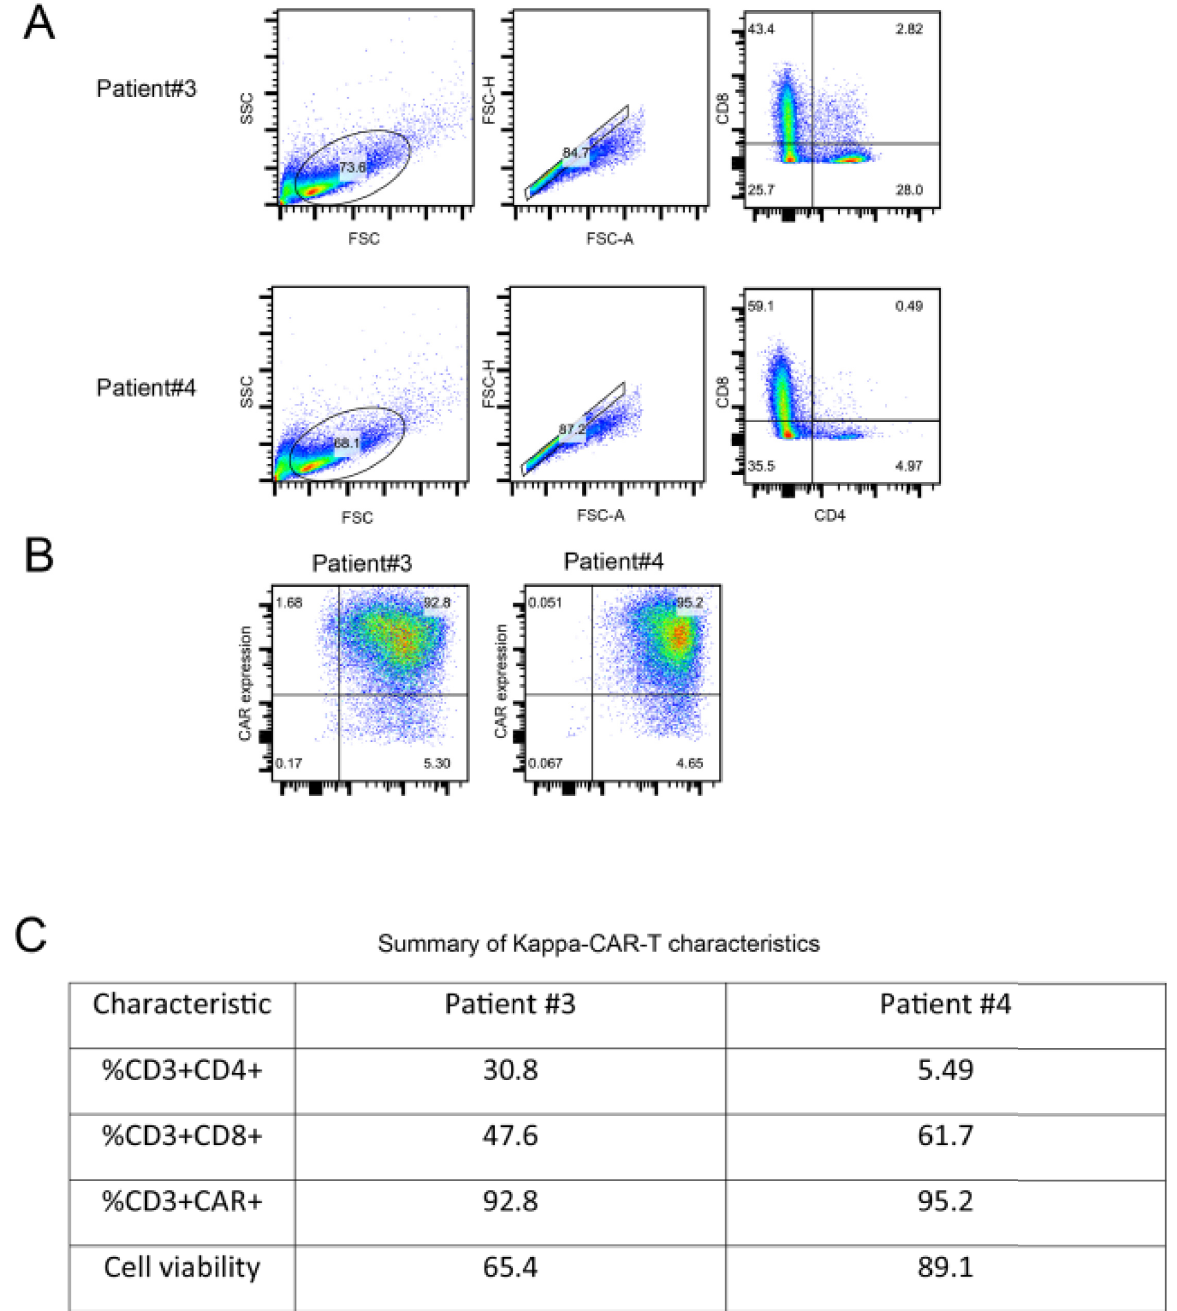
Fig 1. Comparable CAR expressions between patient #3 and patient #4. PBMCs from patients #3 and #4 were transduced with the kappa-CAR retrovirus, respectively. The ratio and expression (MFI) of CD8 and CD4 subsets are calculated. (A) Flow cytometry analysis of CD8 and CD4 positive population from patients #3 and #4. (B) The ratio of CD3 and CAR positive subsets is calculated. (C) Different subsets of CD3 + T cells and viability are summarized. Data are pooled from at least two independent